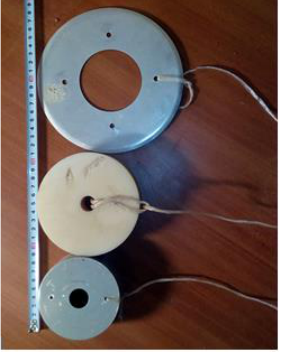
Figure 20. Test objects.